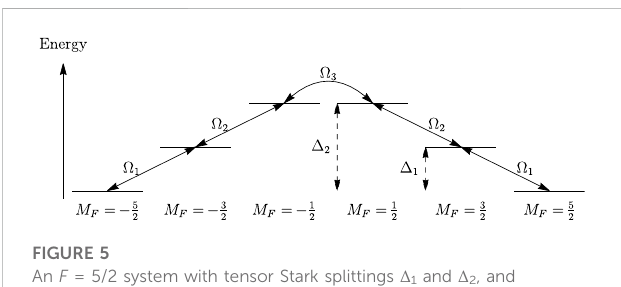
FIGURE 5 An F = 5/2 system with tensor Stark splittings Δ 1 and Δ 2 , and couplings Ω 1 , Ω 2 , Ω 3 between states of adjacent M F .